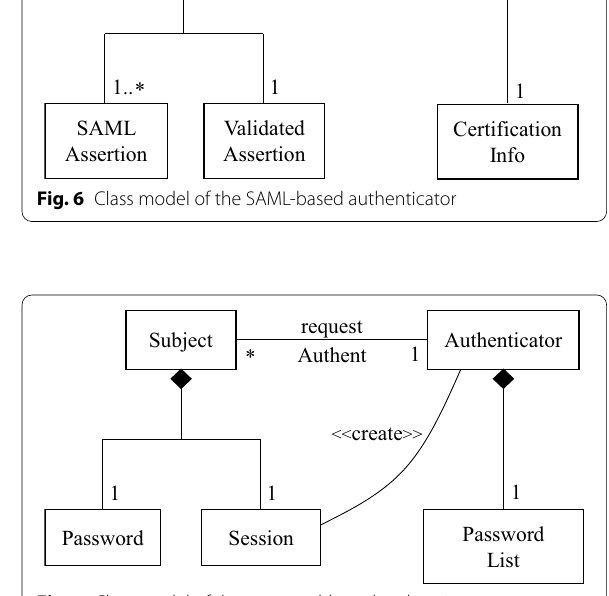
Fig. 7 Class model of the password-based